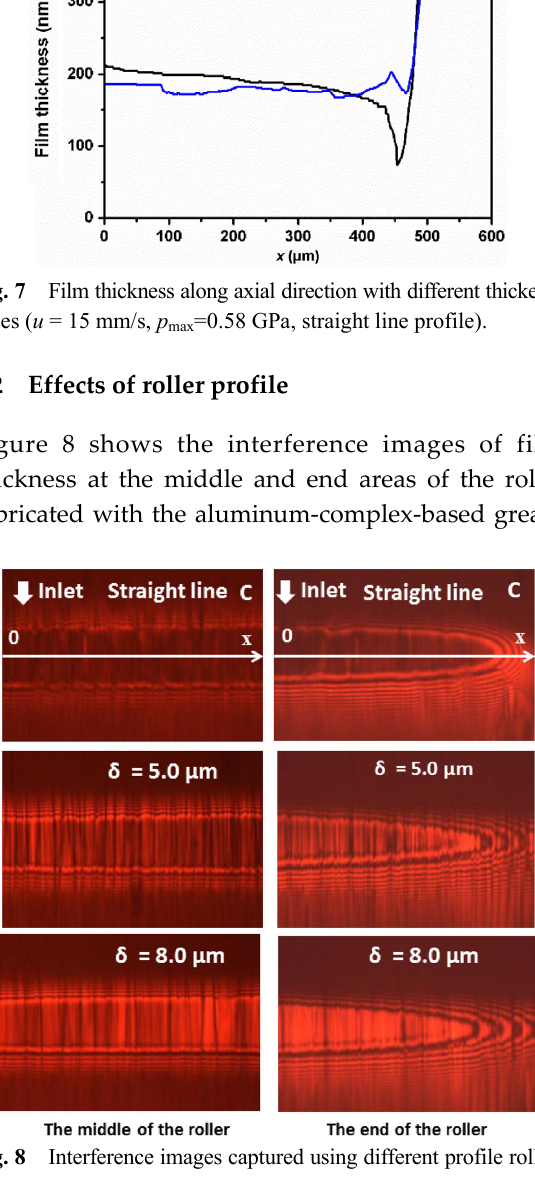
Fig. 6 Schematic of dry contact pressure for straight line profile roller.